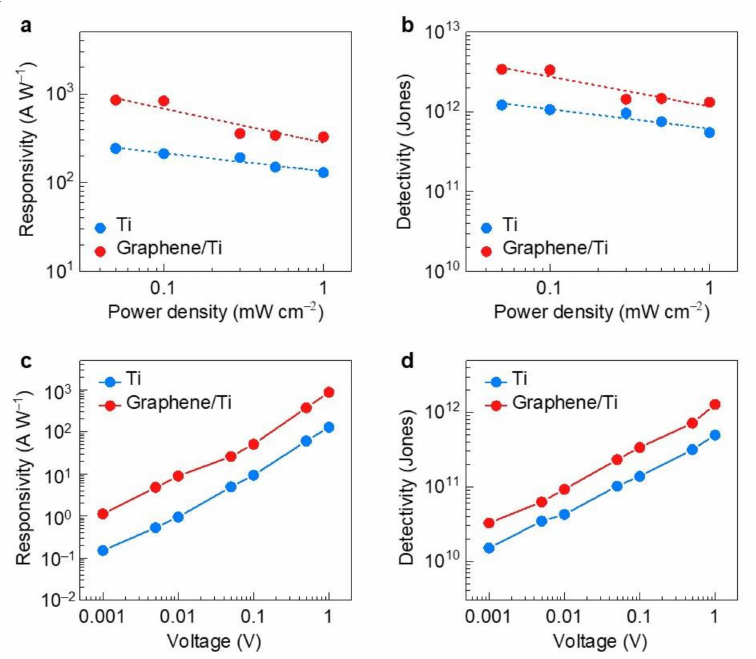
Figure 4. ( a ) Responsivities and ( b ) detectivities of MoS 2 devices with Ti and graphene/Ti contacts under an applied bias of 1 V and V G = 0 V and light illumination at 470 nm as a function of light power density. ( c ) Responsivities and ( d ) detectivities of MoS 2 devices with Ti and graphene/Ti contacts under light illumination at 470 nm as a function of an applied bias, under V G = 0 V. All graphs were acquired from the data in Figure